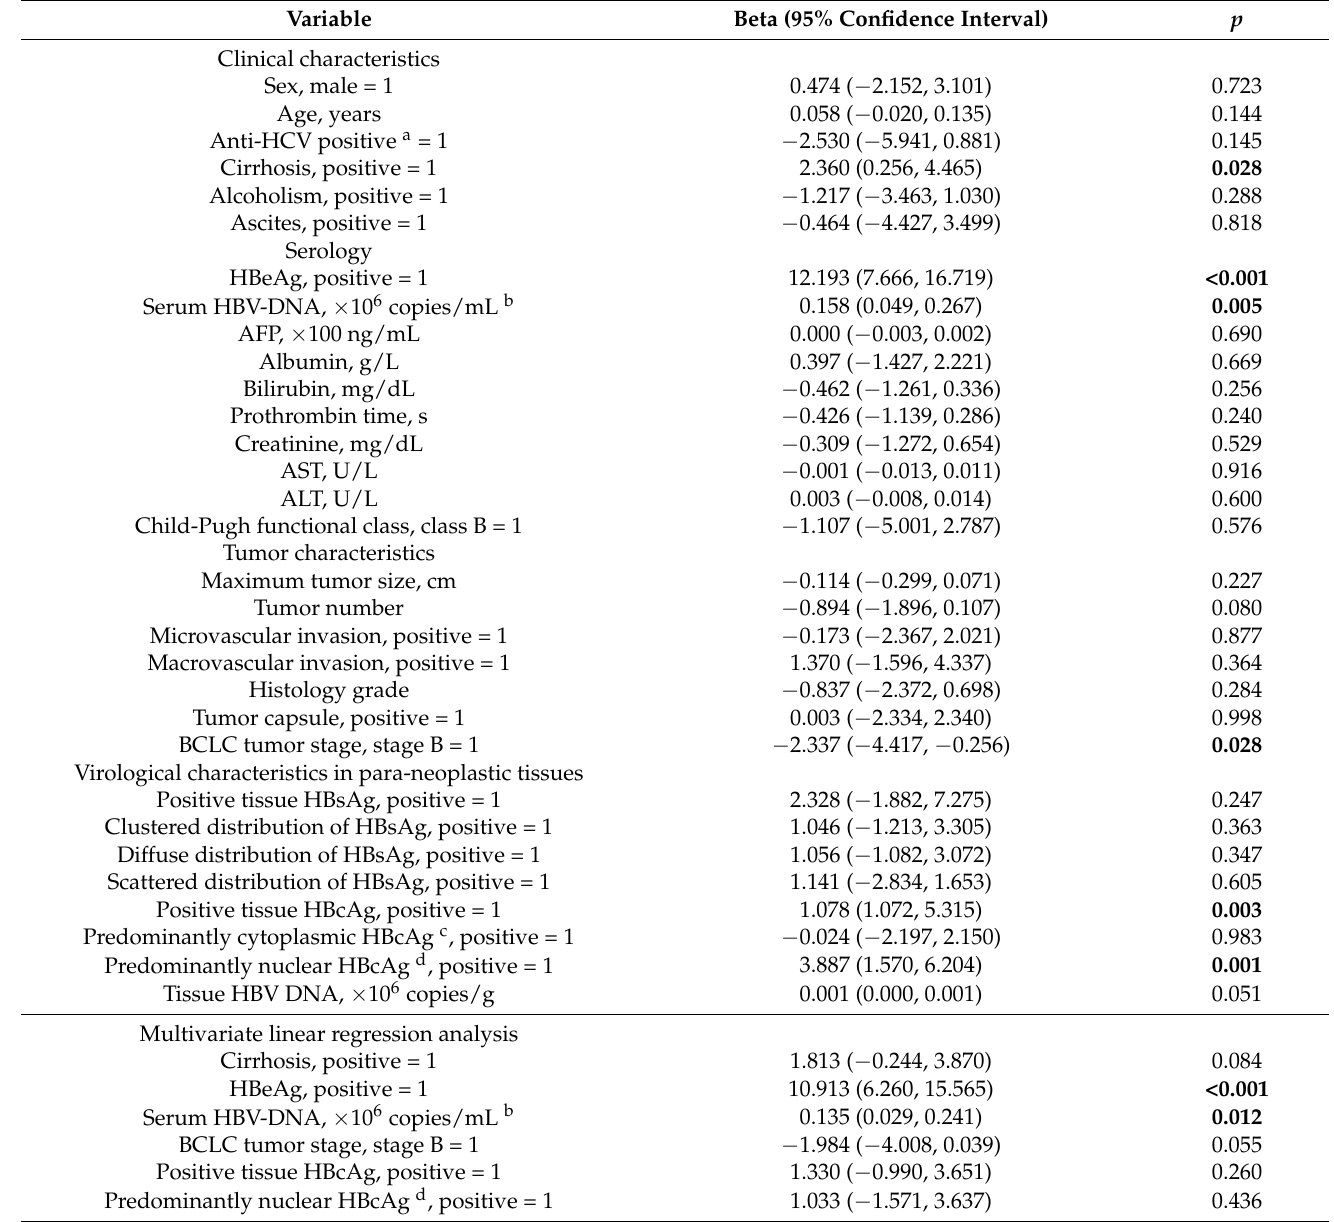
Table 2. Linear regression analysis of tissue HBV cccDNA in relation to clinicopathological and virological